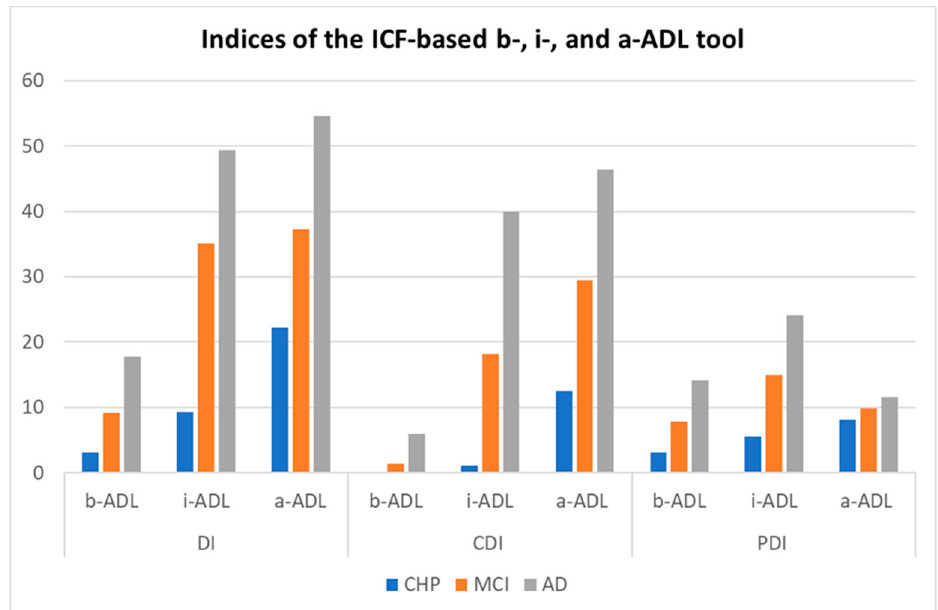
Figure 1. Functioning of cognitively healthy persons ( n = 47), patients with MCI ( n = 39) and patients with mild AD ( n = 44) measured with the BIA indices expressed as percentages. Legend—ICF: International Classification of Functioning, Disability and Health; CHP: Cognitively Healthy Persons; MCI: Mild Cognitive Impairment; AD: Alzheimer’s Dementia; ADL: Activities of Daily Living; b-: basic; i-: instrumental; a-: advanced; DI: Disability Index; CDI: Cognitive Disability Index; PDI; Physical Disability Index. Indices expressed as percentages.